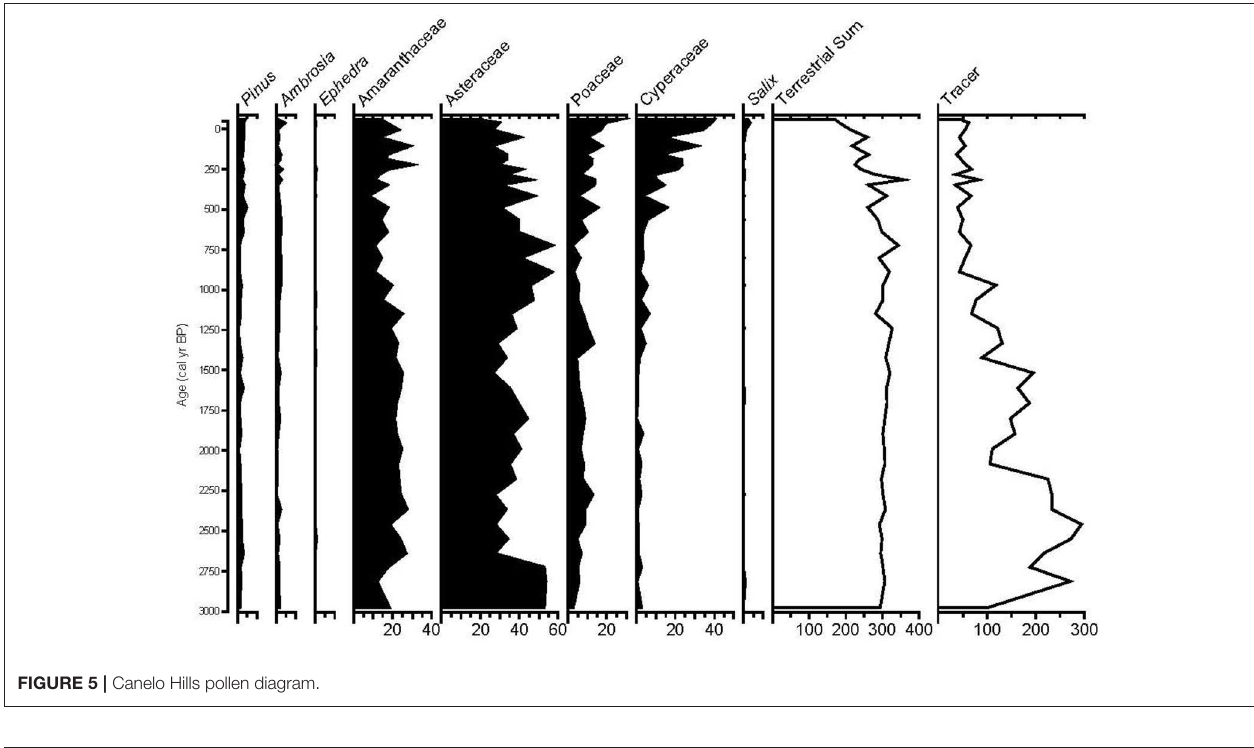
FIGURE 5 | Canelo Hills pollen diagram.